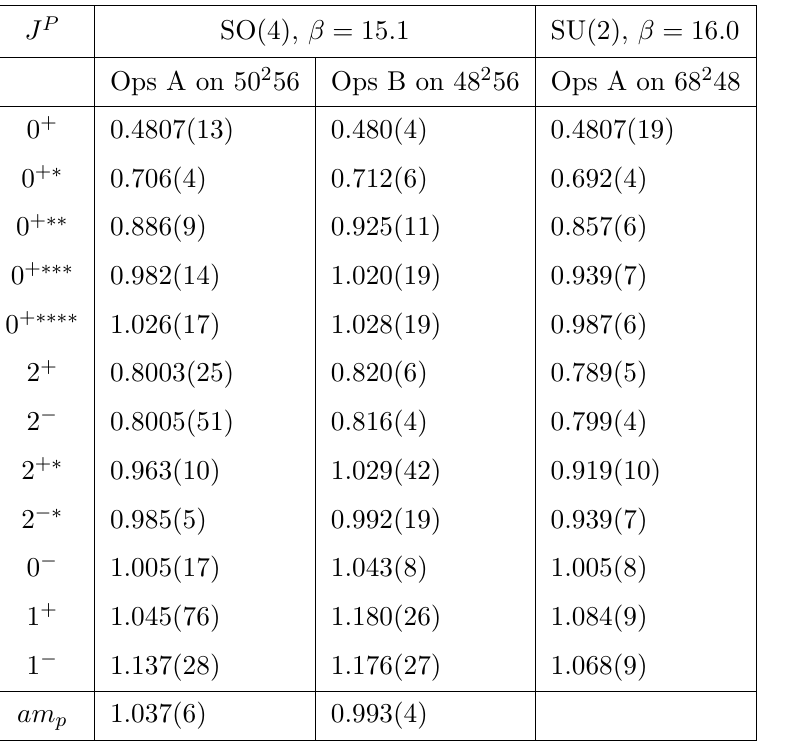
Table 2 . Spectrum at (cid:12) = 15 : 1 in SO(4) using two di(cid:11)erent operator bases. Also an SU(2) calculation using basis A, with masses rescaled up by a factor 1.169 to a common mass gap. Also the (cid:13)ux loop mass, am p